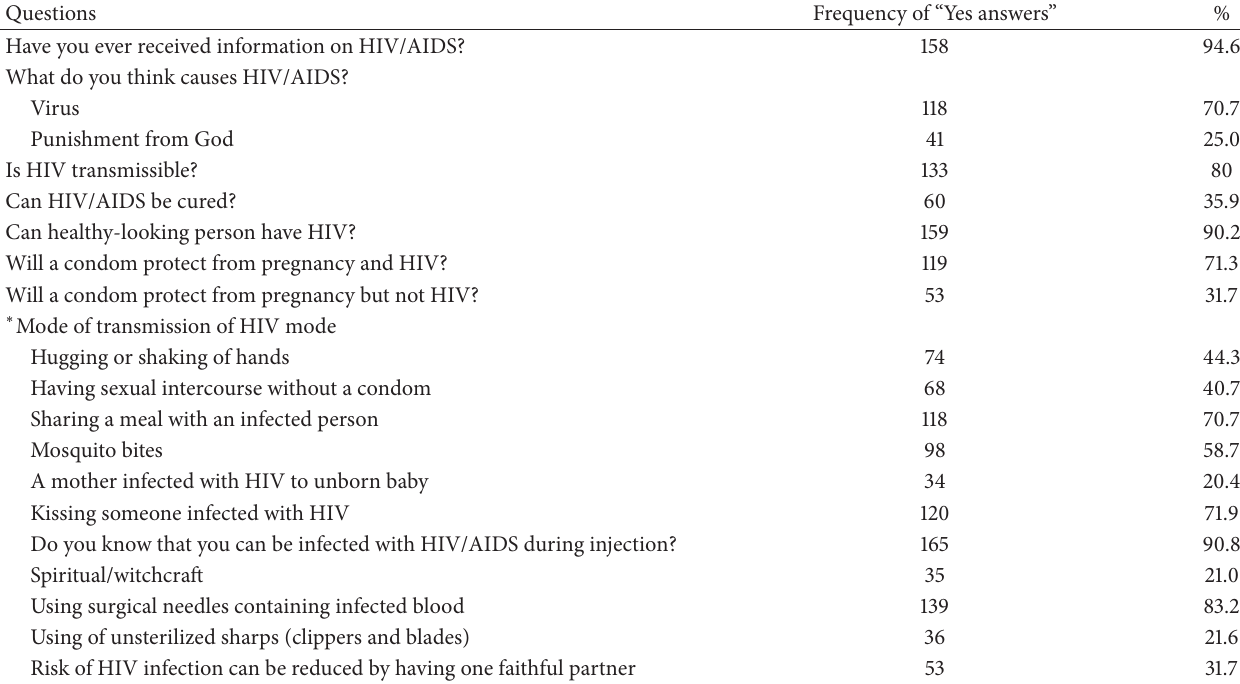
Table 2: Knowledge of HIV/AIDS by respondents.